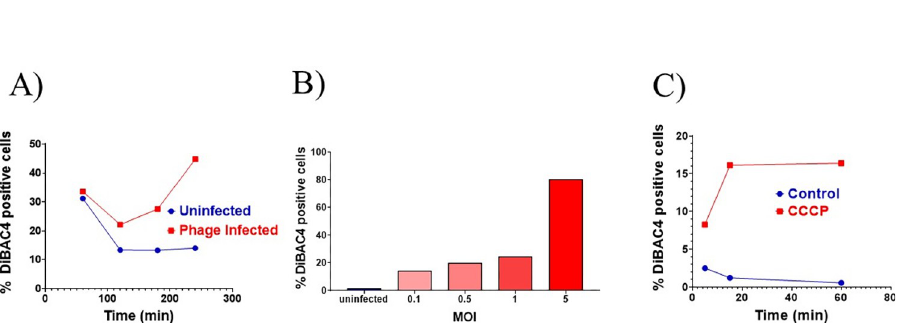
Fig 5. Membrane depolarization assay performed using DiBAC 4 . Fluorescence intensity was measured by flow cytometry using the FITC channel. The experiments were performed using D29 (A, B) as the depolarizing agent or CCCP (C). CCCP was used at a concentration of 3.2 μ g/ml.